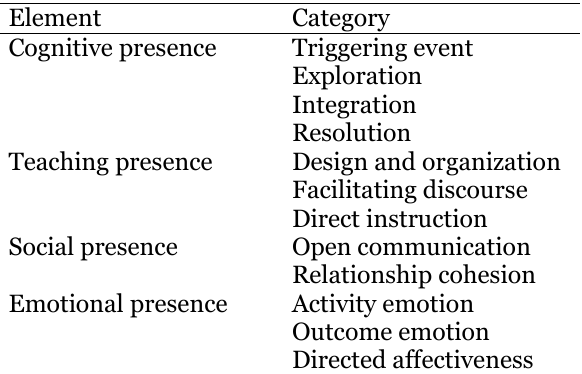
The Relationship of Inquiry